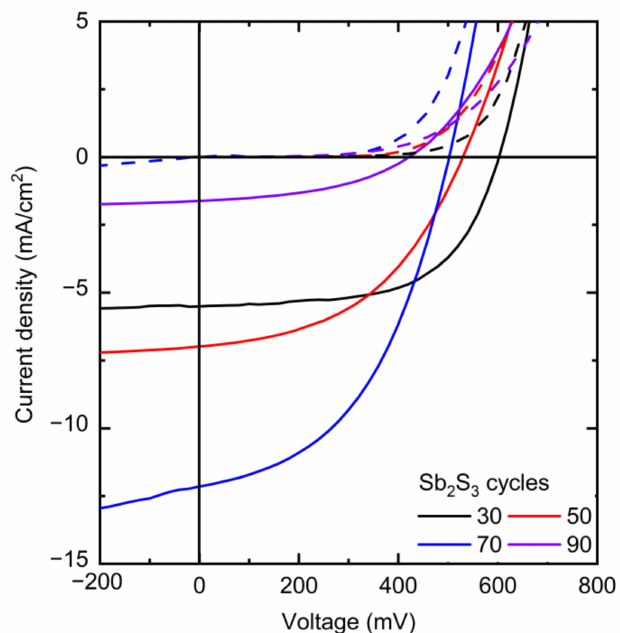
Figure 8. J – V curves of the best ETA solar cells made of ZnO/TiO 2 core–shell NW heterostructures covered with a Sb 2 S 3 shell grown by CSP, using 30, 50, 70, and 90 cycles, collected under dark (dashed lines) and AM 1.5 G illumination (solid lines)